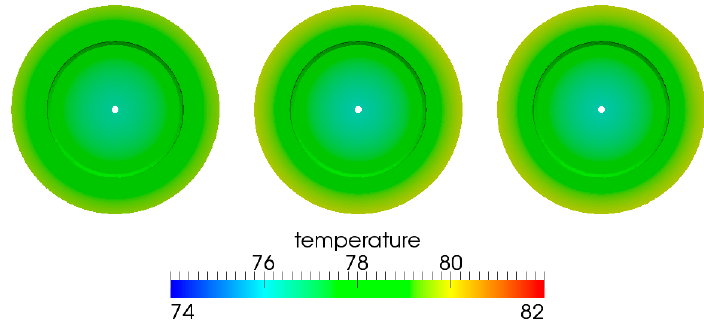
Figure 22. Slipper temperature distribution comparison for different sizes.